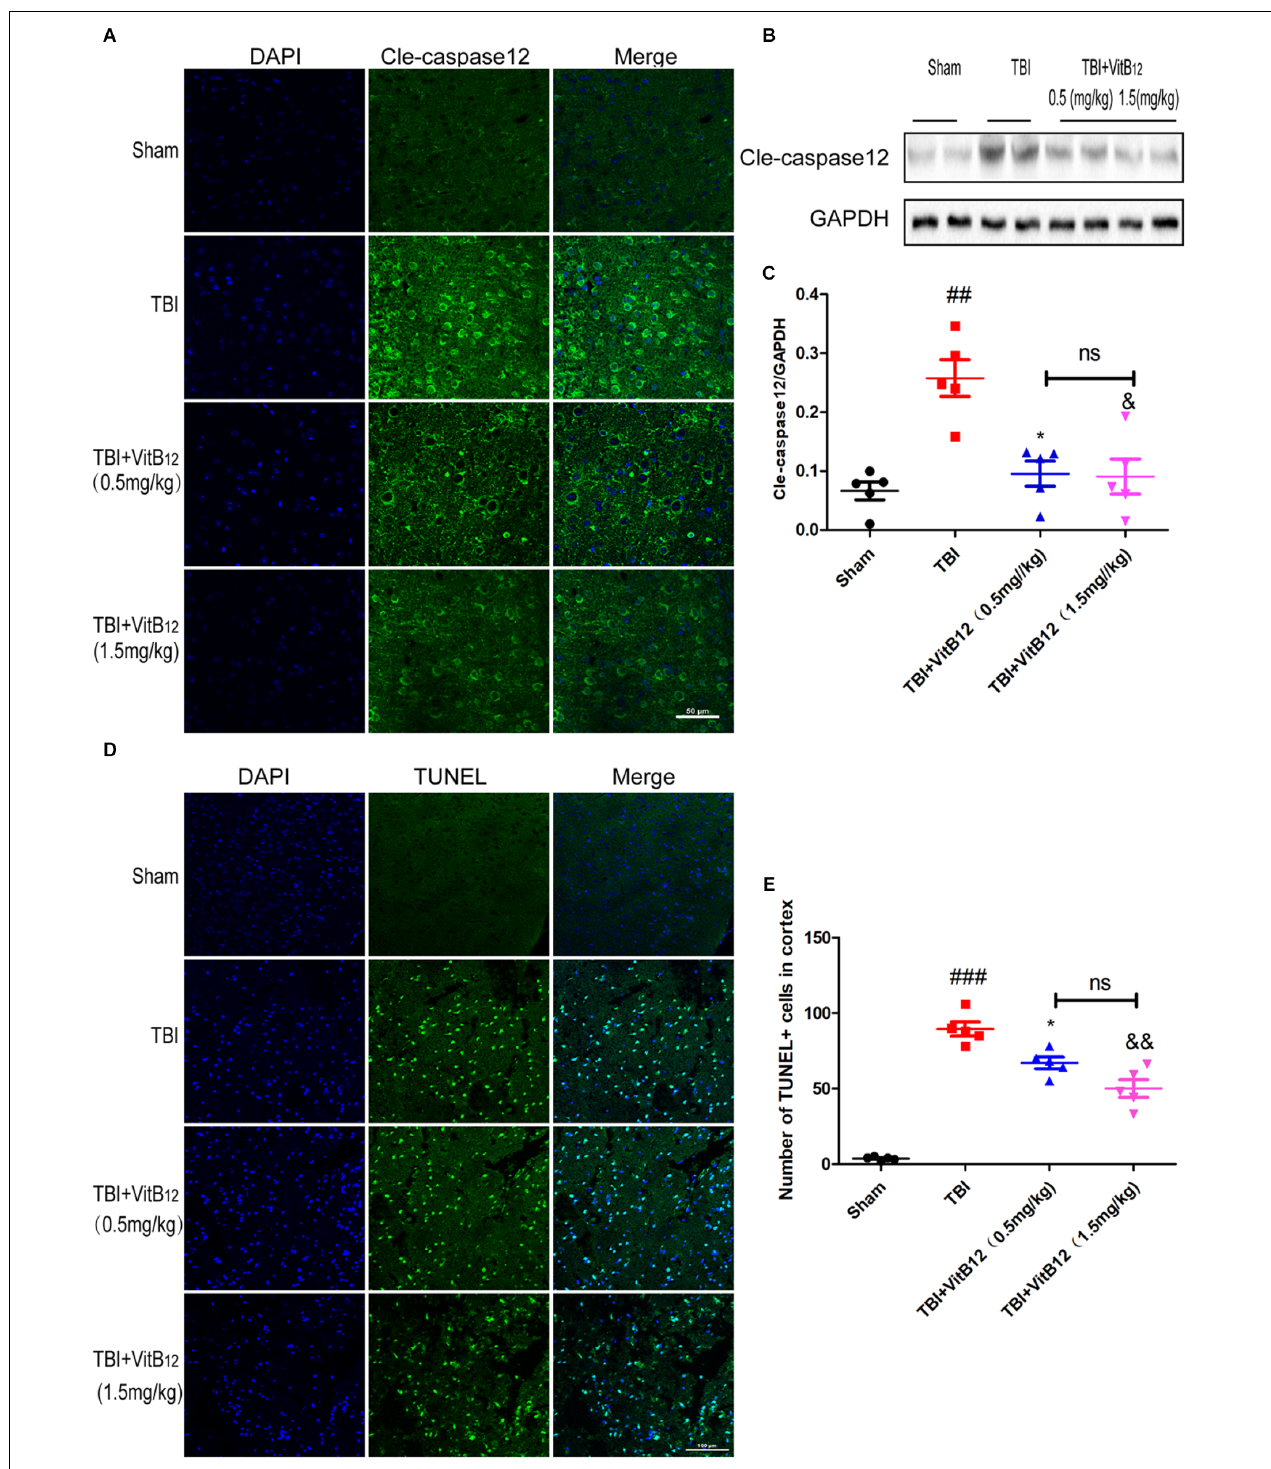
FIGURE 2 | Vitamin B12 protects neurons from apoptosis. (A) Immunofluorescence staining of cleaved caspase-12 (green) in the cortex at 7 days post-injury. Scale bar = 50 µ m. (B,C) The expression and quantification of cleaved caspase-12 proteins in the cortex in the 7 days post-injury. ## P < 0.01 vs. the sham group. ∗ P < 0.05 and & P < 0.05 vs. the TBI group values represent the mean ± SEM, n = 5. (D,E) Representation and quantification of immunofluorescence staining of TUNEL (green) in the cortex at 7 days post-injury. ## P < 0.01 vs. the sham group. ∗ P < 0.05 and & P < 0.05 vs. the TBI group values represent the mean ± SEM, n = 5. Scale bar = 100 µ